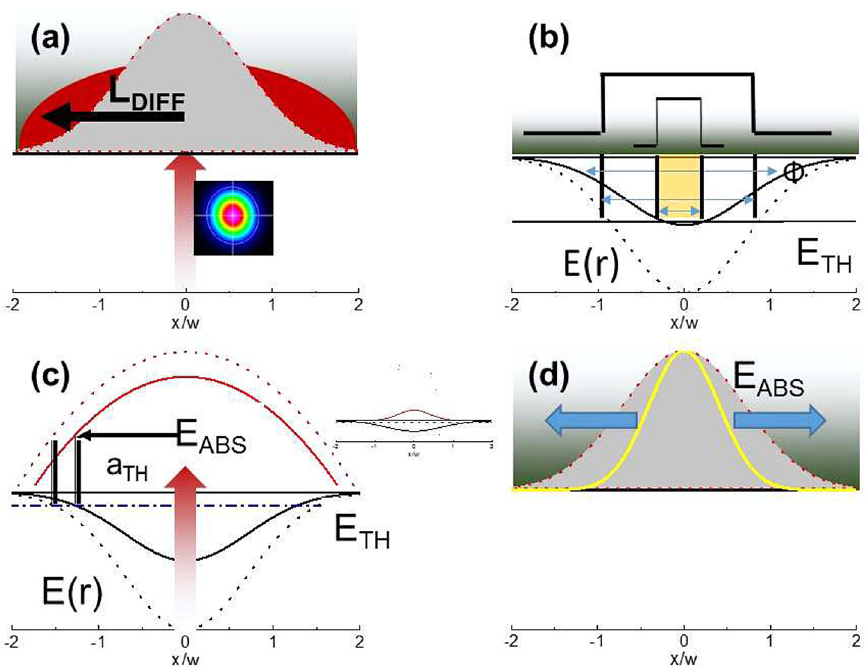
Figure3: (a)Competitionbetweenopticallimitsandenergydiffusion.Energydiffusesthermallyoutsideoftheopticalconcentrationareaona range given by the diffusion length L DIFF . It is to be noted that the spread of energy can give ablative effects if the energy concentration stays roughly above the vaporization threshold or structural material modi fi cations below this value. (b) Threshold fi ltering of ablative areas.